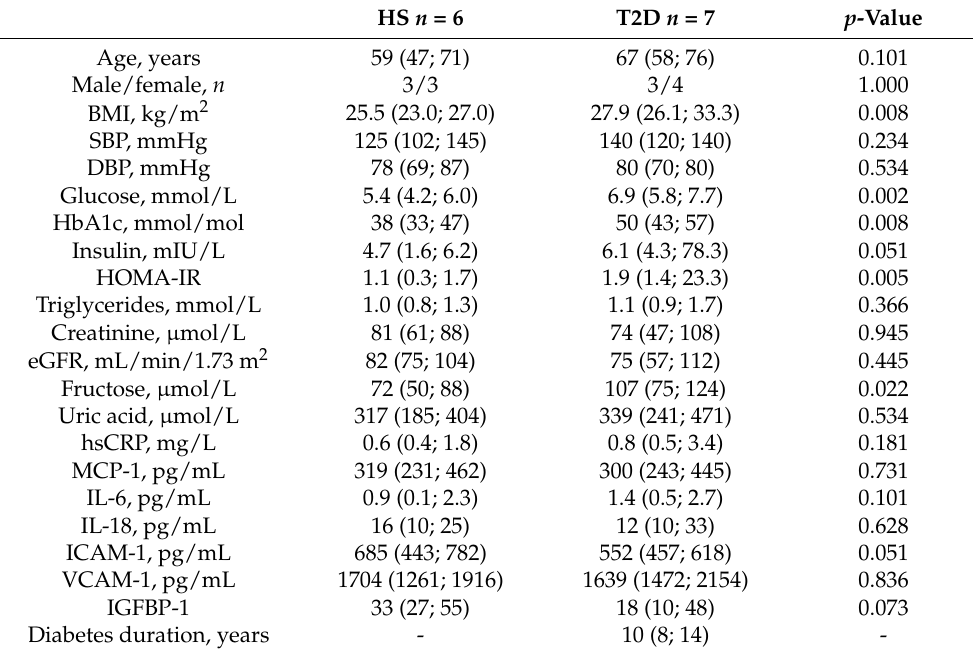
Table 1. Characteristics of study population